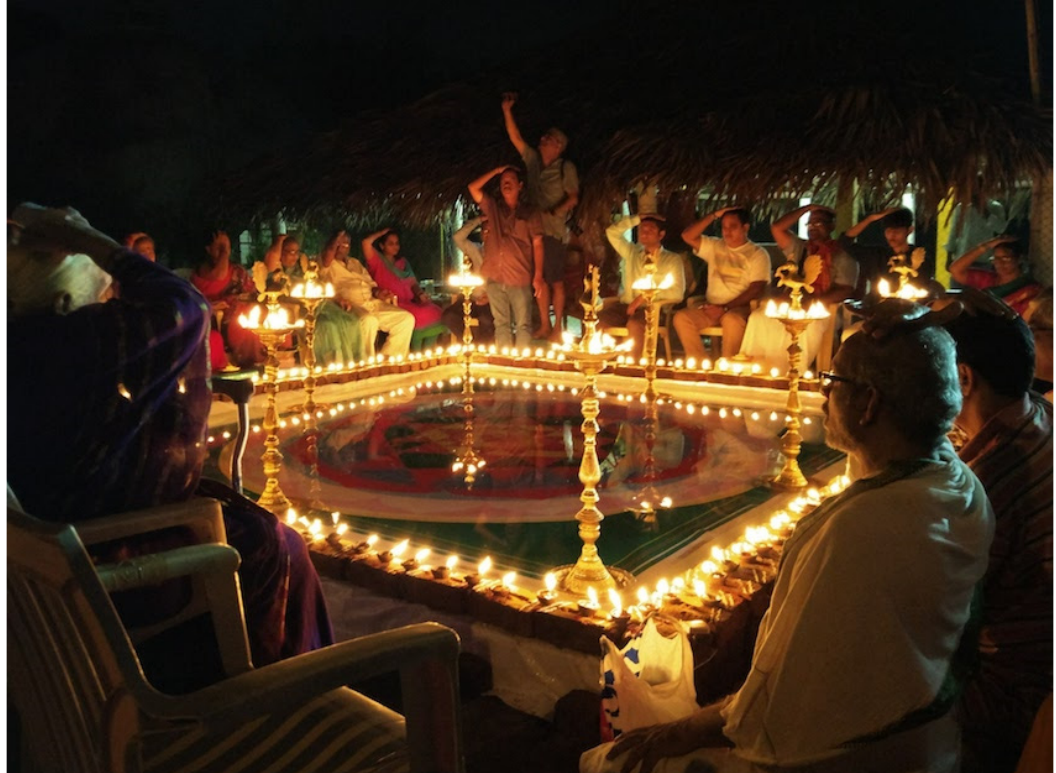
Figure 13. Sir ī jyotip ū j ā . Credit: author.